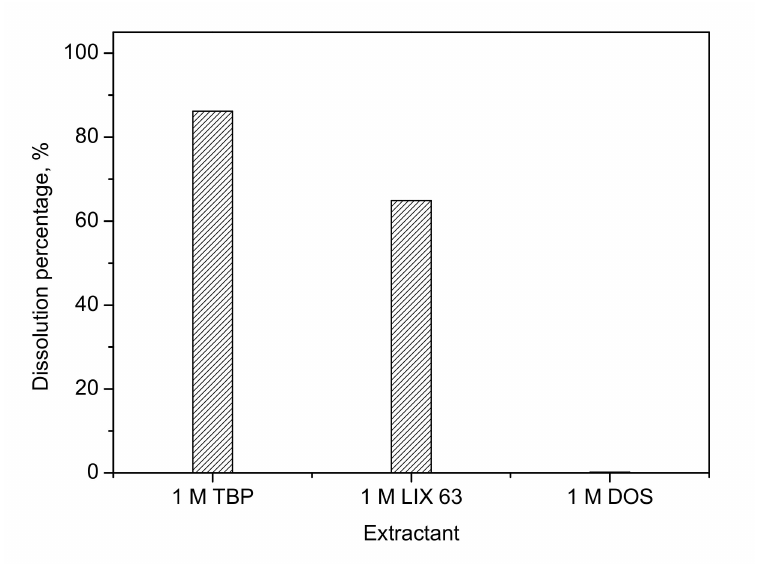
Figure 1. Effect of the nature of the extractants on the dissolution of Pd. Conditions: extractant = 1 M; diluent: kerosene; Pd/extractant ratio = 1.25 g/L; Pd/HCl ratio = 10 g/L; Pd/H 2 O 2 ratio = 10 g/L; 60 ◦ C, 60